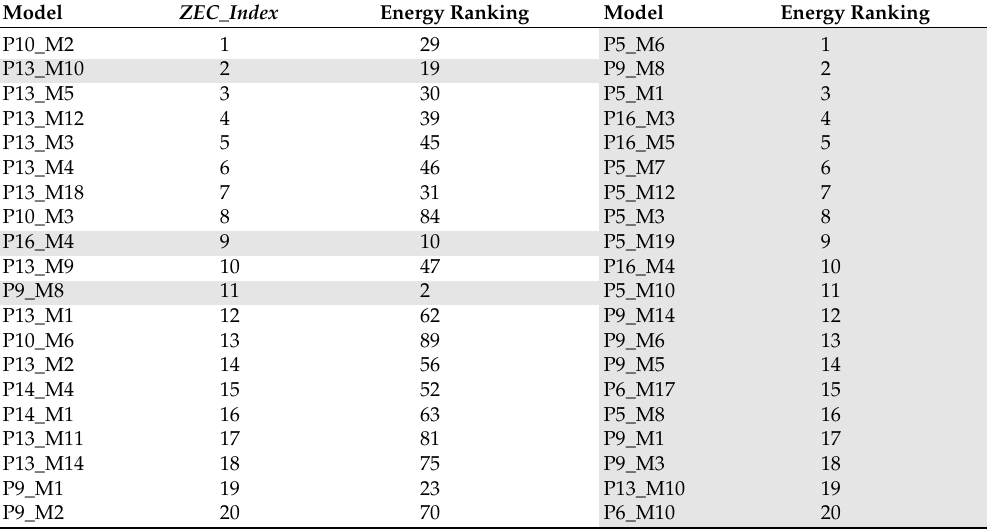
Table 10. (Real case) On the left of the table, ranking ascending by ZEC _ Index and with reference to its energy position. On the right, ranking ascending by energy. The shaded text corresponds to the 20 best energy